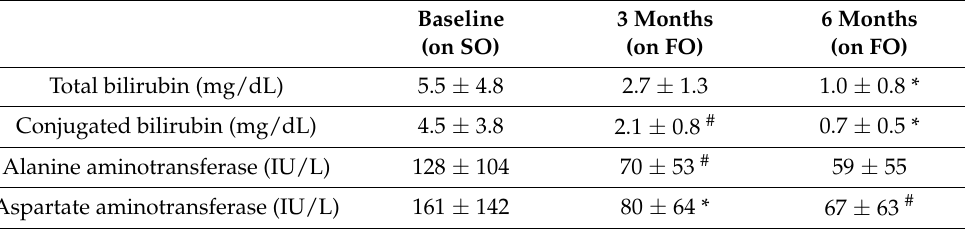
Table 3. Liver function tests in children treated with fish oil.